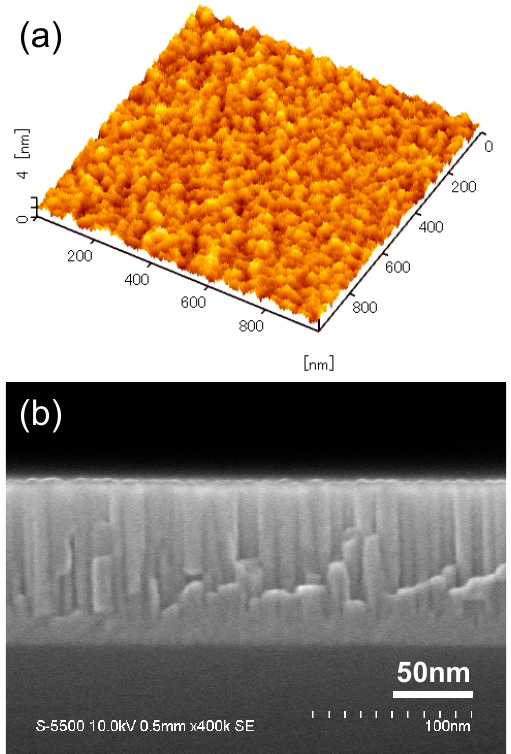
Figure 2. ( a ) Dynamic force microscopy (DFM) image of the surface (1 μ m × 1 μ m) of aluminum nitride (AlN) film (in chip size) deposited at a substrate temperature of 973 K and ( b ) cross-sectional scanning electron microscopy (SEM) image of the AlN layer deposited on SiC.